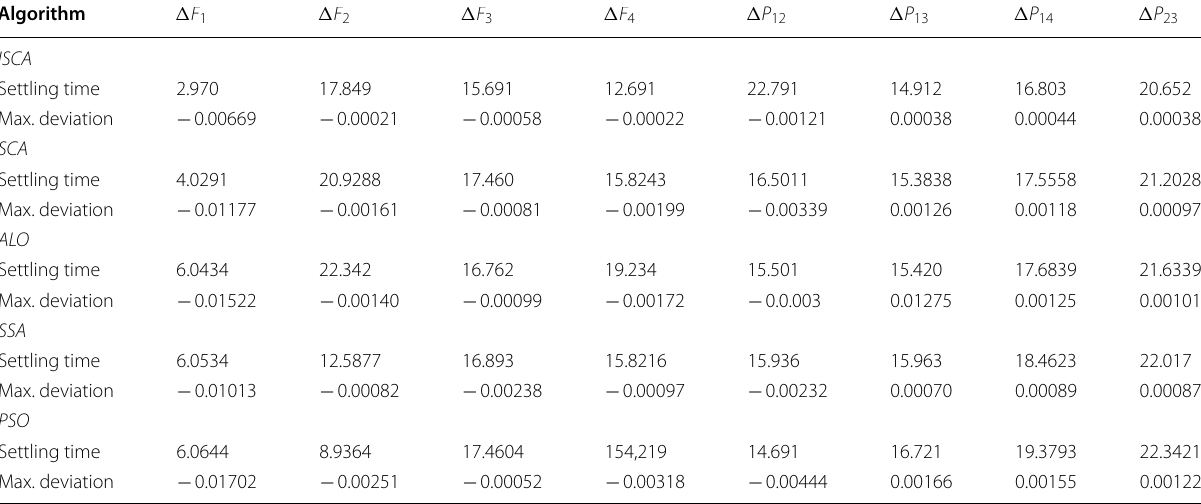
Table 10 Performance parameters of LFC with ISCA, SSA, ALO, SCA and PSO in the case of SLD of 2% in area-1 of the four-area